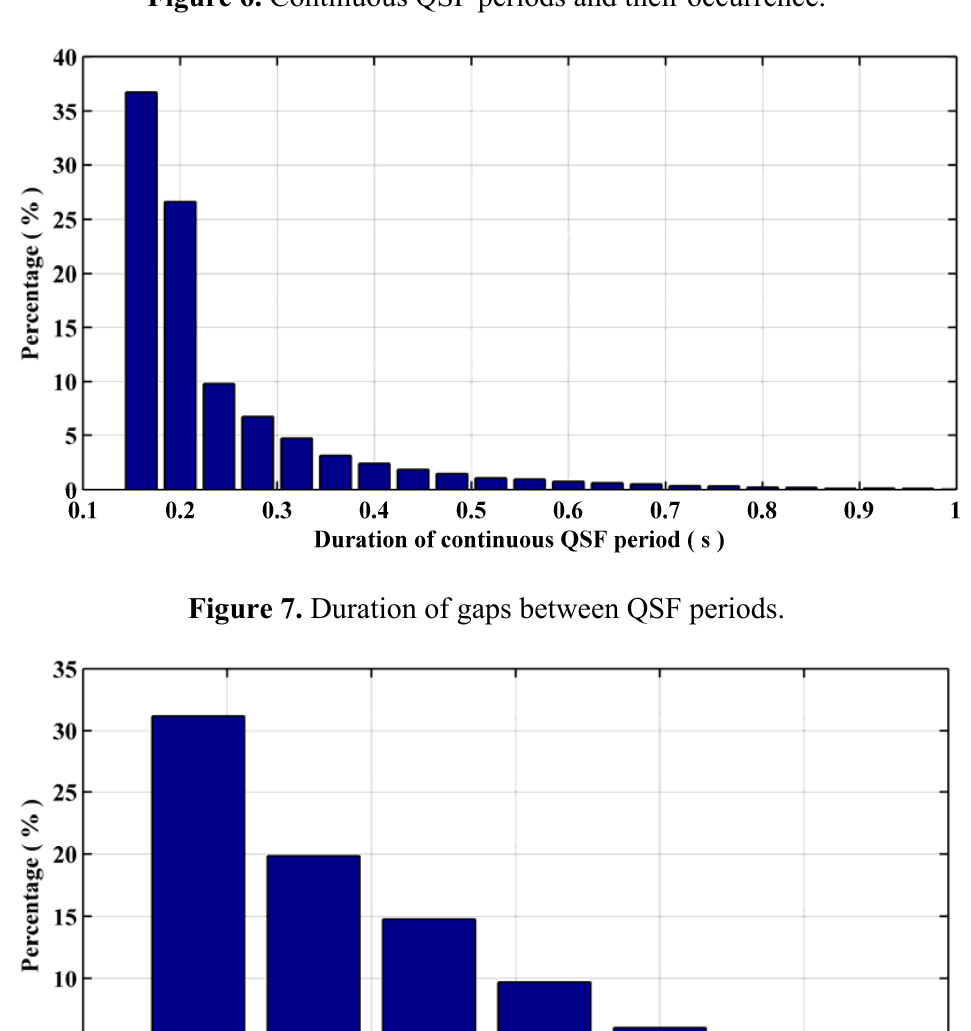
Figure 6. Continuous QSF periods and their occurrence.